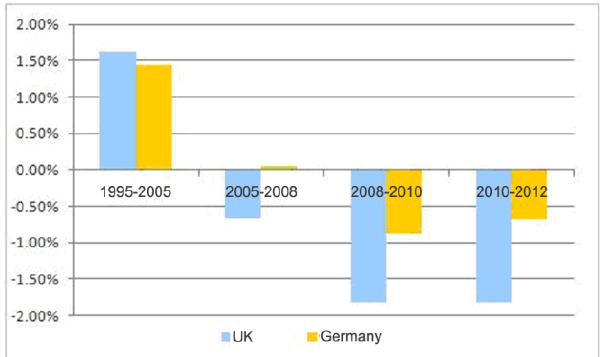
Figure 1. Electricity consumption, average yearly % change over the following periods: 1995 – 2005,